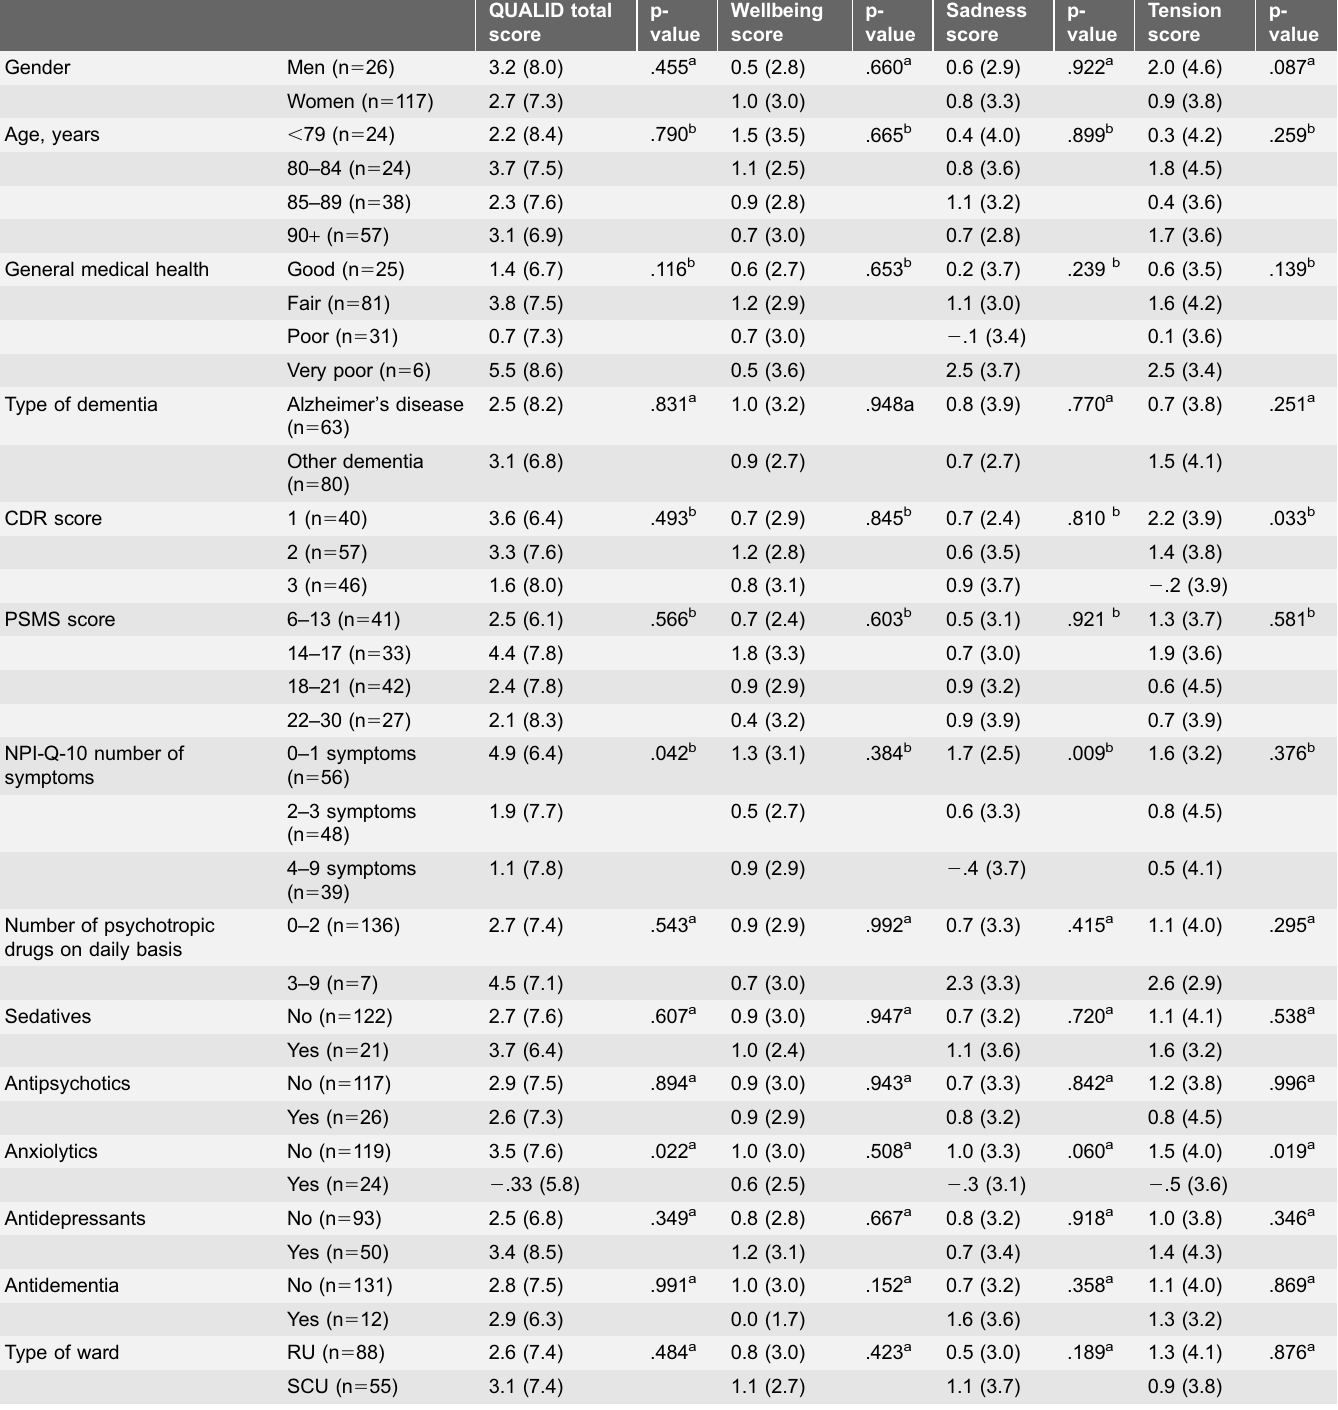
Table 3. Changes in mean scores, total, wellbeing, sadness and tension QUALID scores, between baseline and follow-up (follow-up – baseline) for various patient characteristics.